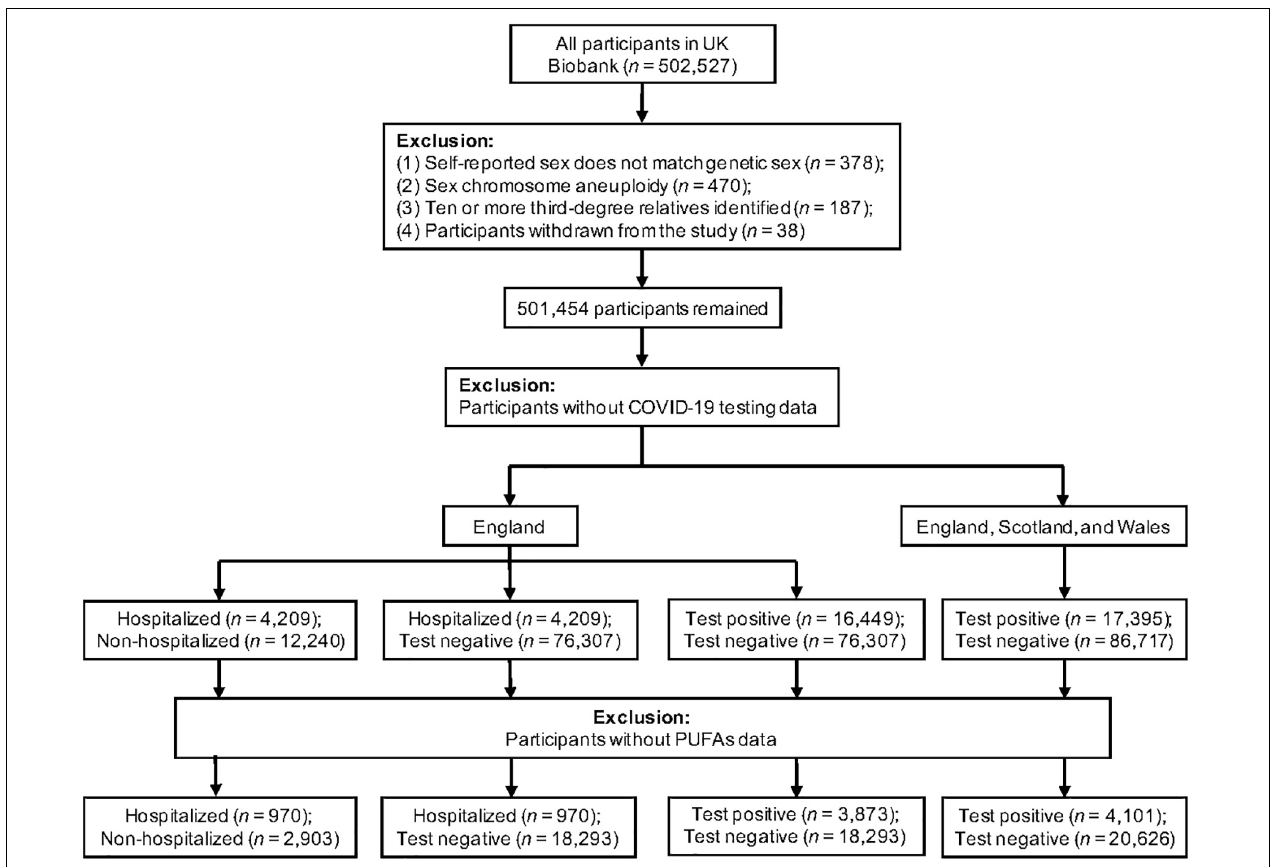
FIGURE 1 | Flowchart of the UK Biobank participants from recruitment to inclusion in the observational analysis.